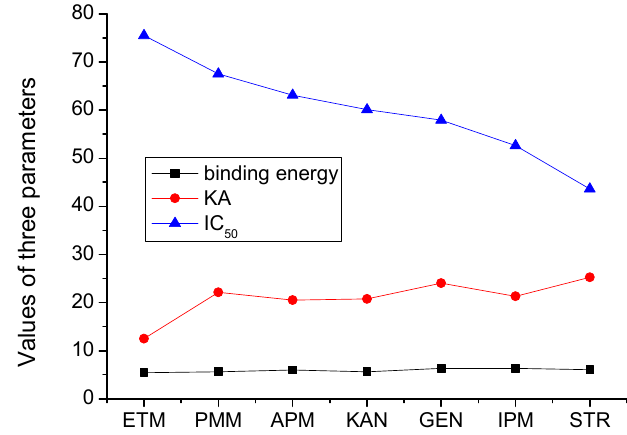
Figure 8. Integration of KA, IC 50 , and binding energy of the 7 AGs.